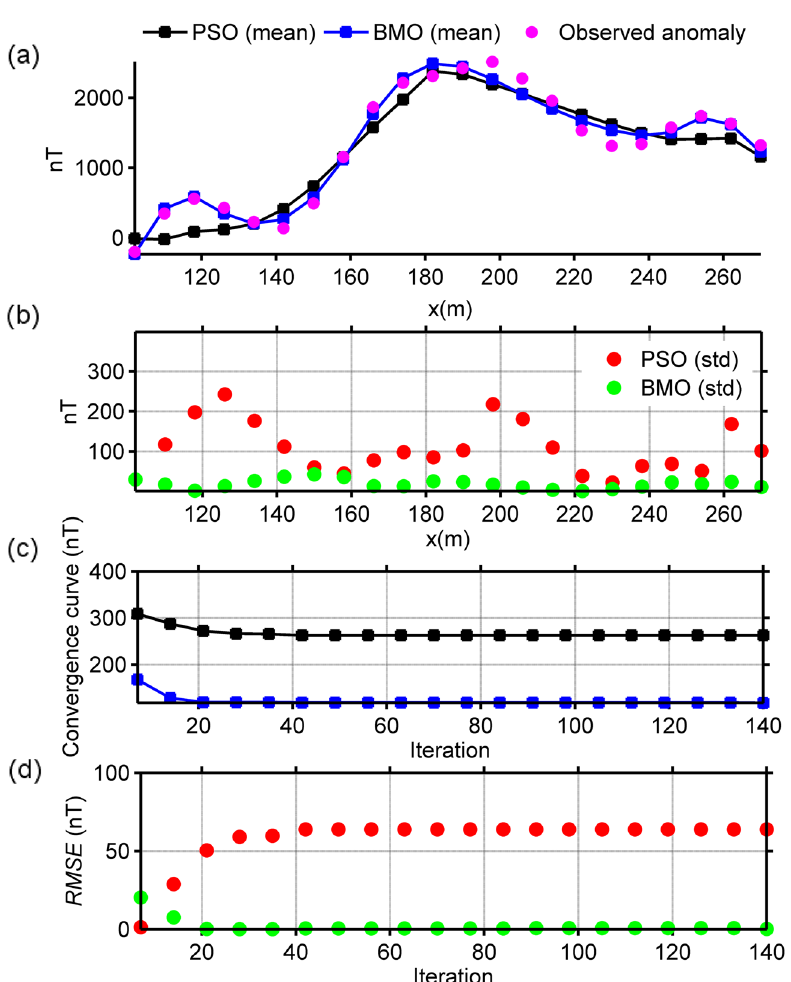
Figure 15. Inversion results of the uranium ore anomaly, India. ( a ) fittings between the observed magnetic anomaly and the mean responses obtained via BMO and sPSO, ( b ) calculated std values of obtained responses at each station, ( c ) variation behavior of the mean RMSE values against iterations of BMO and sPSO after 30 independent runs, ( d ) variation behavior of the std of RMSE values against iterations of BMO and sPSO after 30